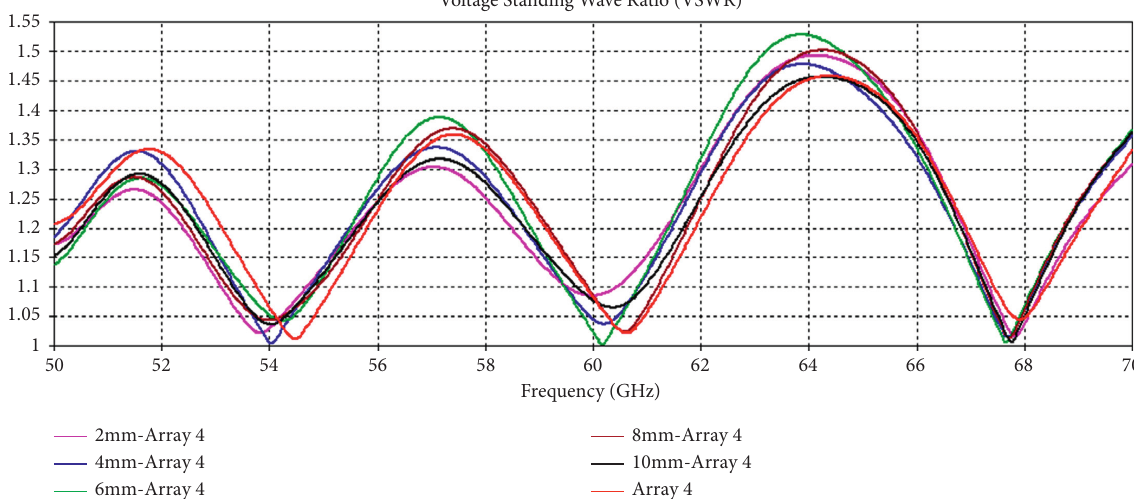
Figure 30: Array 4 on-body VSWR at different distances compared to free space.